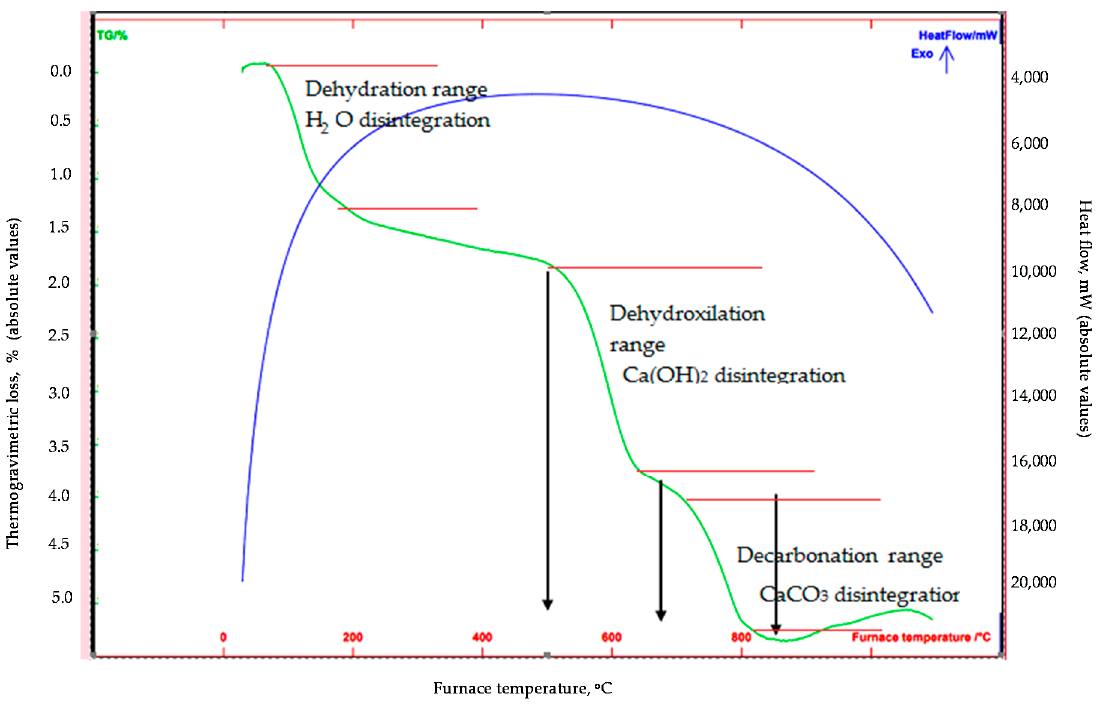
Figure 2. DT/TGA curves of the investigated DM material.